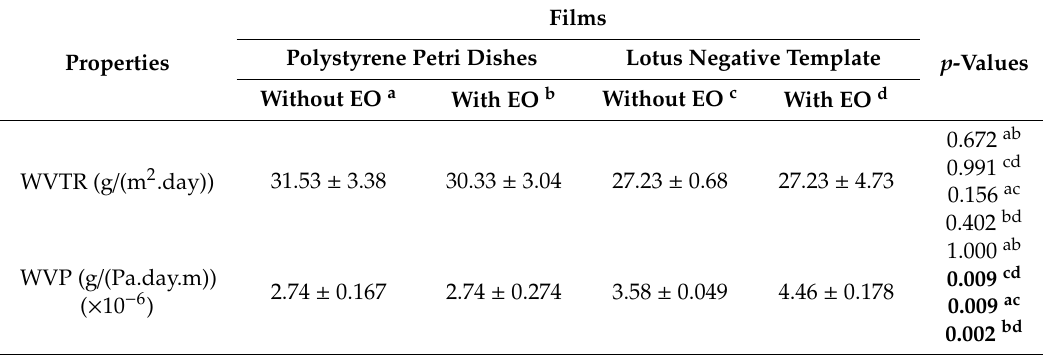
Table 2. Barrier properties of the films: water vapor